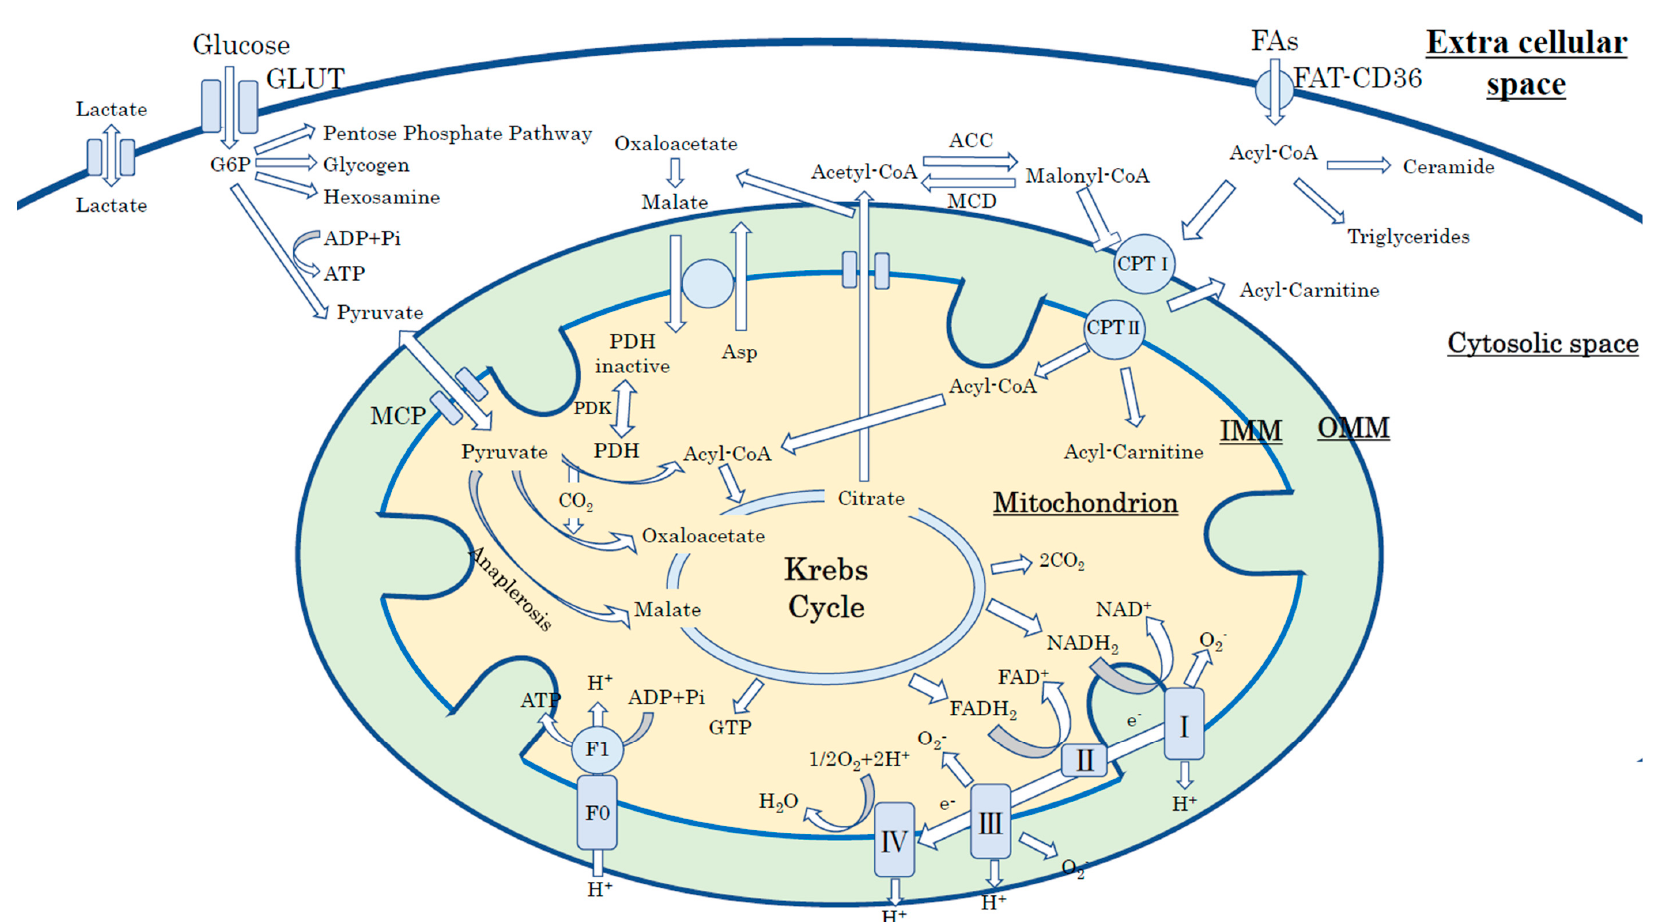
Figure 1. Cardiac energy metabolism in the physiological condition. FAs, fatty acids; GLUT, glucose transporter; FAT-CD36, fatty acid translocase; G6P, glucose-6-phosphate; MPC, mitochondria; OMM, outer mitochondrial membrane; IMM, inner mitochondrial membrane; CPT-I/II, carnitine palmitoyltransferase isomers-I/II.